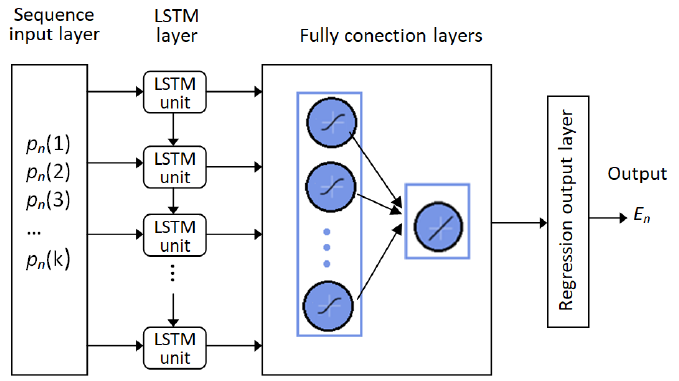
Figure 7. Energy consumption estimation model using a DLNA network.